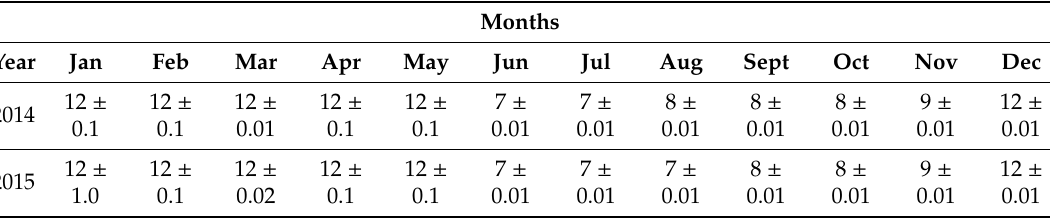
Table 1. Monthly Means values of sun’s UV-B Index for 2014 and 2015.